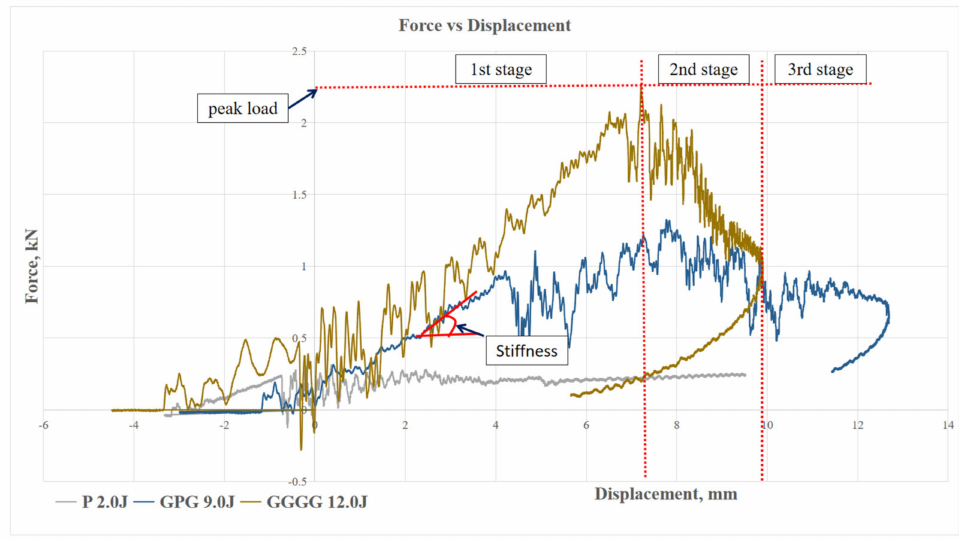
Figure 7. Force–Displacement curve of maximum impact energy prior to composites